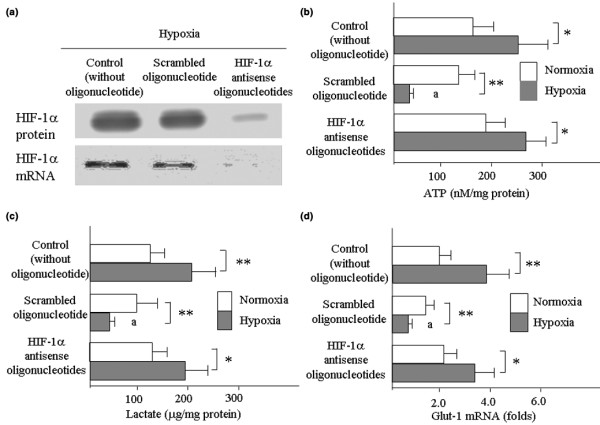
Effect of HIF-1α on ATP production and glycolysis in human articular cartilage. (a)Hypoxia-inducible factor 1α (HIF-1α) depletion by antisense oligonucleotide was assessed by RT-PCR and western blotting analyses. HIF-1α mRNA and protein expressions were reduced in antisense HIF-1α-treated chondrocyte populations. Scrambled oligonucleotide was used as control oligonucleotide. Representative data from four independent experiments are shown. (b)In hypoxia, HIF-1α-deficient chondrocytes showed a significant decrease of free ATP in comparison with control oligonucleotide-treated chondrocytes. Statistical differences were calculated using data from four independent experiments. (c, d) The levels of lactate (c) and glucose transporter-1 (Glu-1) (d) were increased in the scrambled ODN-treated chondrocytes under hypoxic culture conditions compared with normoxic culture condition. In HIF-1α-deficient chondrocytes, both glycolytic activities were reduced under hypoxic conditions. Statistical differences were calculated using data from four independent experiments. aP < 0.01, control oligonucleotide hypoxia vs HIF-1α-deficient hypoxia; *P < 0.05, **P < 0.01.